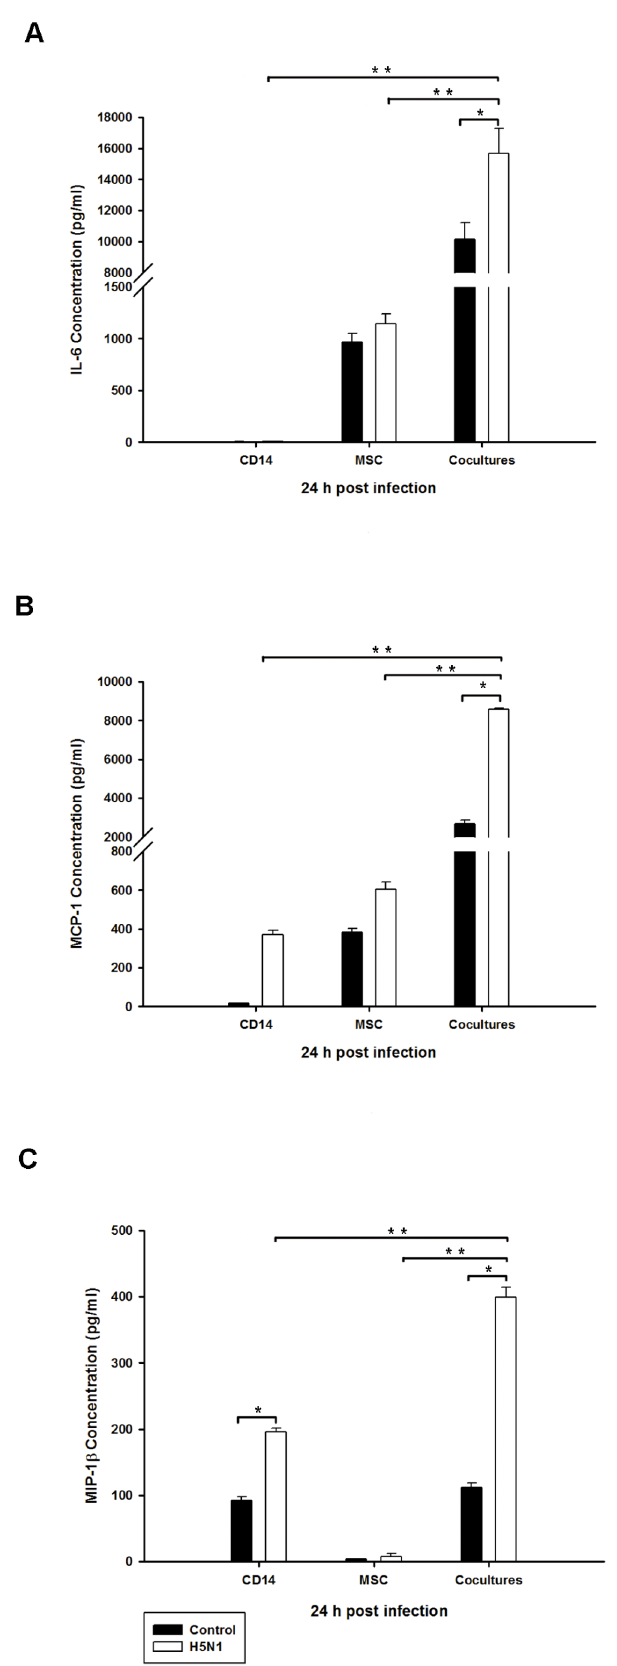
Figure 5. Production of IL-6, MCP-1, and MIP-1 b from H5N1- infected cocultures. ( A ) IL-6, ( B ) MCP-1, and ( C ) MIP-1 b levels from supernatants of infected CD14 + monocytes and MSCs monoculture and 1:5 ratio of MSCs/CD14 + monocytes cocultures at MOI 0.04 were measured by using Bio-plex Cytokine assay. Data was analyzed via Bio- plex 5.0 Software. The two different cell types used in the experiment were derived from different donors. The results represent the means and SD of two independent experiments. Single asterisk indicates statistically significant differences between mock and infected cells with P values of , 0.05 and double asterisks indicate statistically significant differences between cocultures and monoculture groups with P values of ,